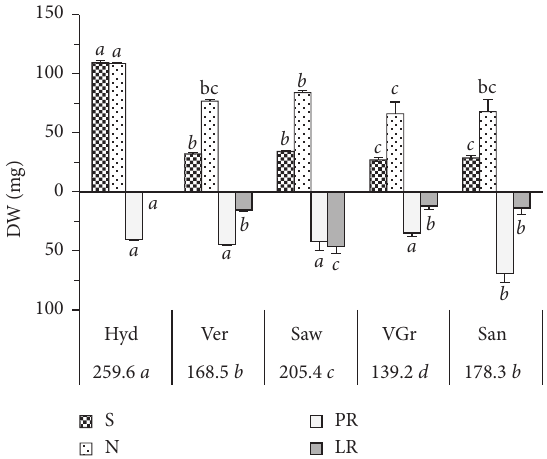
Figure 1: Dry weight (DW) average of cedar seedlings in response to the medium variation. N : Needles, S : stem, PR: main root, and LR: lateral roots. The values at the base of the histograms indicate the average DW of the seedlings. Letters indicate significant dif- ferences ( P < 0 . 05 LSD test). The acronyms of media are as des- ignated as in Table